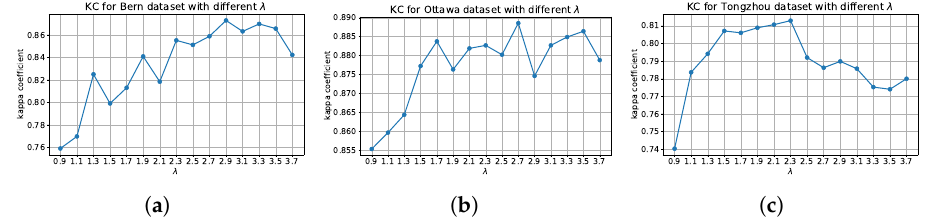
Figure 21. The influence of λ on three datasets. ( a ) Bern dataset. ( b ) Ottawa dataset. ( c ) Tongzhou